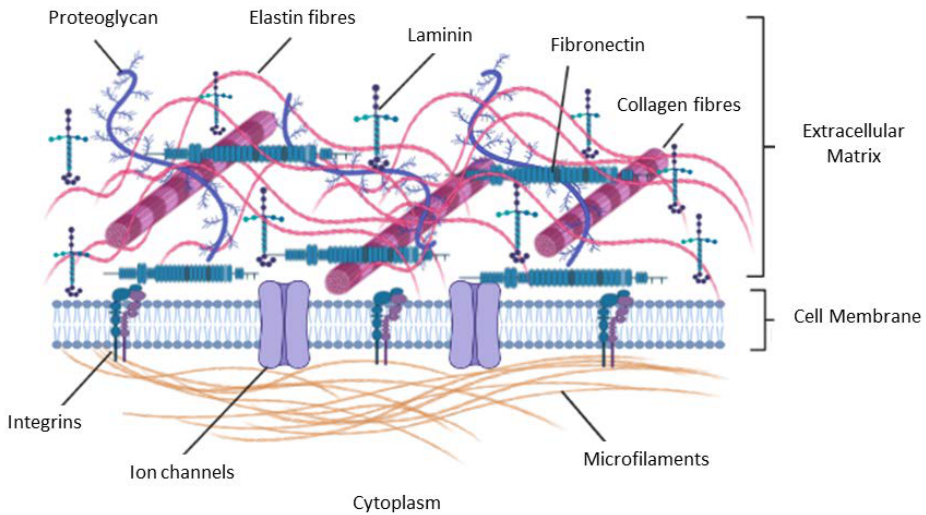
Figure 5. Components of the ECM include glycoproteins, collagens, proteoglycans, and polysaccha- rides. Collagens and glycoproteins are ligand for integrins and play key roles in tumor cell signaling necessary for survival.